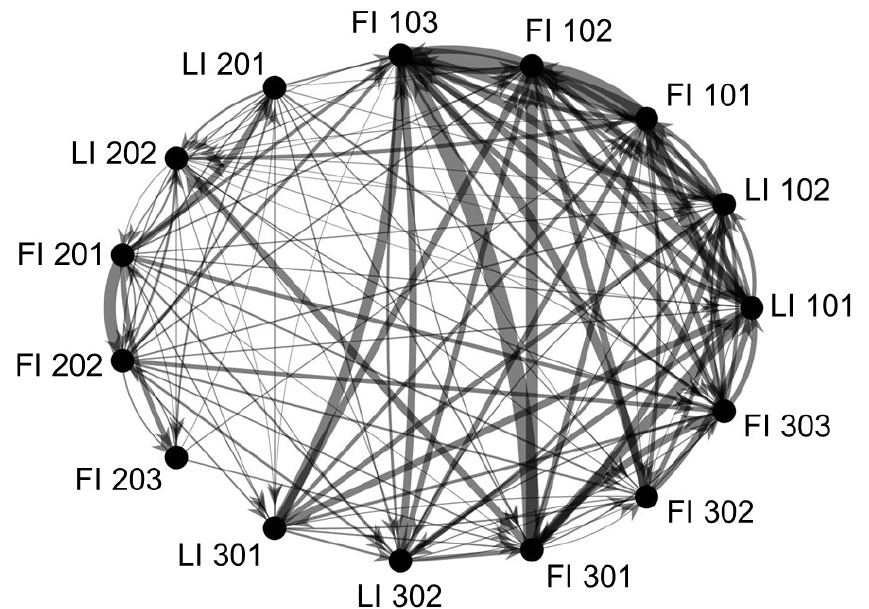
Figure 6. Standard causality map to identify the fault in the tank network. The true root cause is a faulty valve on line FI 203. Edge weights represent magnitude of causal influence (measured by the G-causality index defined in Section 2.1). The first number in each tag name indicates its PS. LI, level indicator; FI, flow indicator.